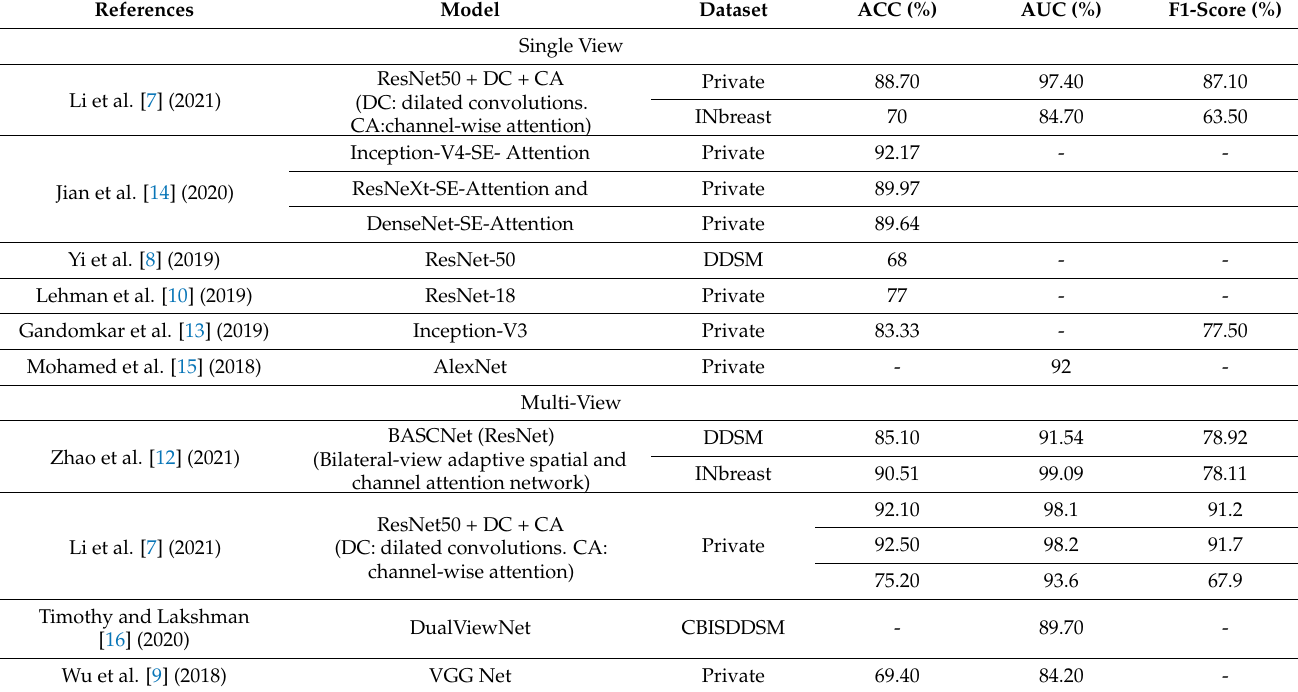
Table 1. The comparison with different state-of-the-art methods for breast density